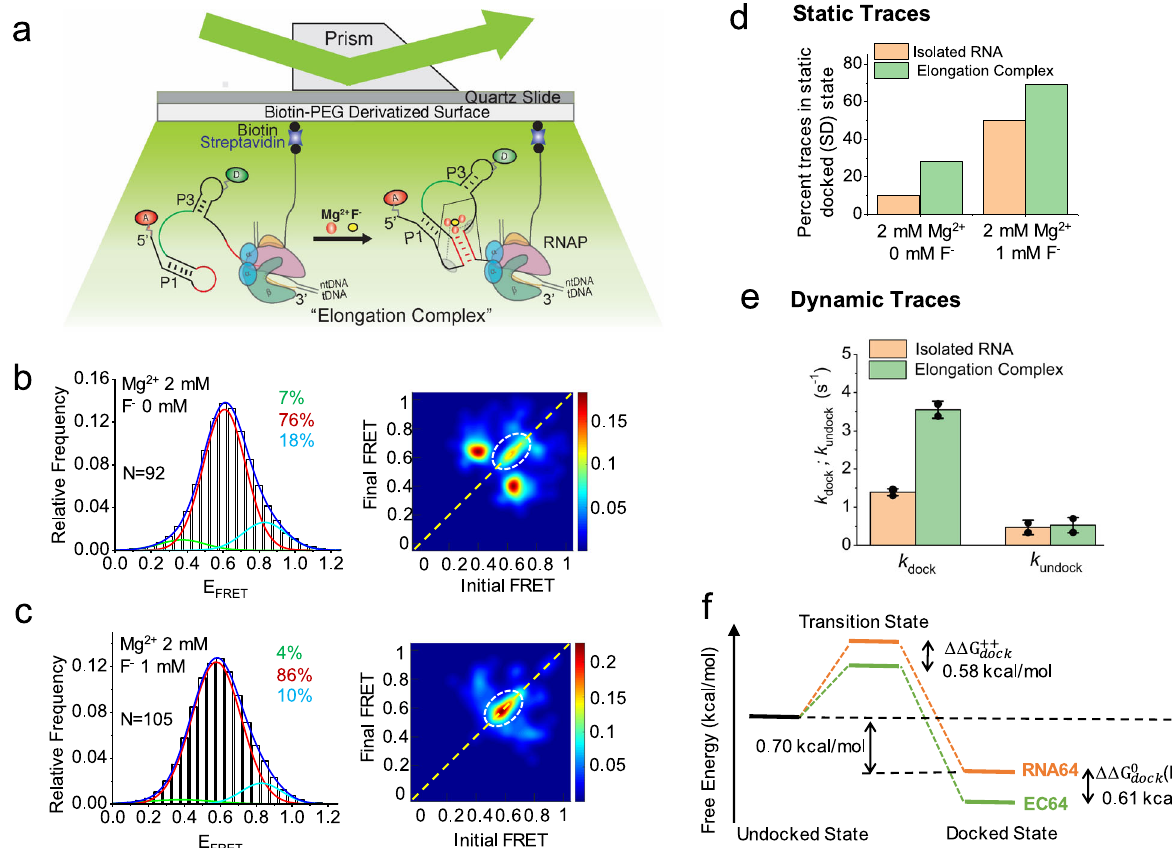
Fig. 4 The presence of RNA polymerase favors the docked conformation of RNA64. ( a ) smFRET experimental setup for probing elongation complexes. RNA is immobilized through biotinylated E. coli RNAP. ( b, c ) FRET histograms and corresponding TODPs in the presence of only 2 mM Mg 2 + ( b ) and in the presence of both 2 mM Mg 2 + and 1 mM F - ( c ). Histograms are well fi tted with three Gaussian peaks, shown in green, red and cyan for the low-, mid-, and high-FRET states, respectively, with the cumulative fi t shown in blue. The percent population of all fi tted peaks are shown in respective colors in each FRET histogram panel, and the number of molecules that were analyzed is indicated by “ N ” . A dashed white circle highlights the presence of the SD conformation in both TODPs. ( d ) Percent of all traces that remain statically in the mid-FRET (docked) state for isolated RNA (orange) and ECs (green) both in the presence of 2 mM Mg 2 + only (left) and in the presence of both 2 mM Mg 2 + and 1 mM F - (right). ( e ) Kinetic parameters for the unfolded-to-folded docked (low- to mid-FRET) transition in the presence of 2 mM Mg 2 + . The error bars are presented as ± standard deviation for n = 2 independent datasets (with the values as k dock : 1.4 ± 0.1 s -1 and k undock : 0.5 ± 0.2 s -1 for isolated RNA and k dock : 3.6 ± 0.2 s -1 and k undock : 0.5 ± 0.2 s -1 for EC). Reliable kinetic parameters could not be obtained in the presence of F - due to the low prevalence of dynamic traces. ( f ) Free energy diagram for RNA64 (orange) and EC64 (green) in the presence of 2 mM Mg 2 + . The relative free energies of the undocked and docked states were obtained from the dwell times in the docked and unfolded states, while the relative barrier heights were obtained using single-molecule transition state analysis